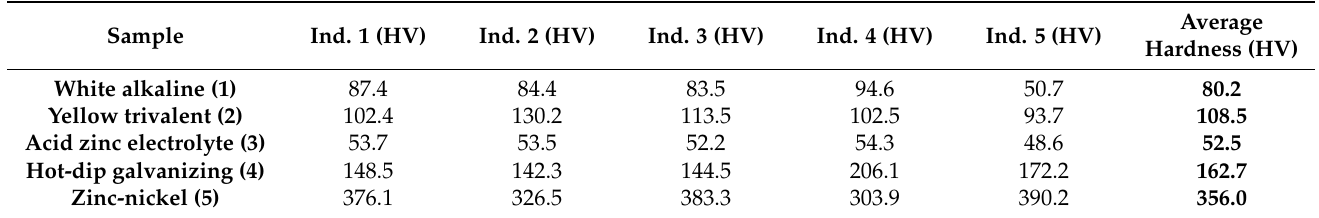
Table 2 gathers the results of the Vickers hardness test on each of the five samples. Table 2. Vickers hardness.